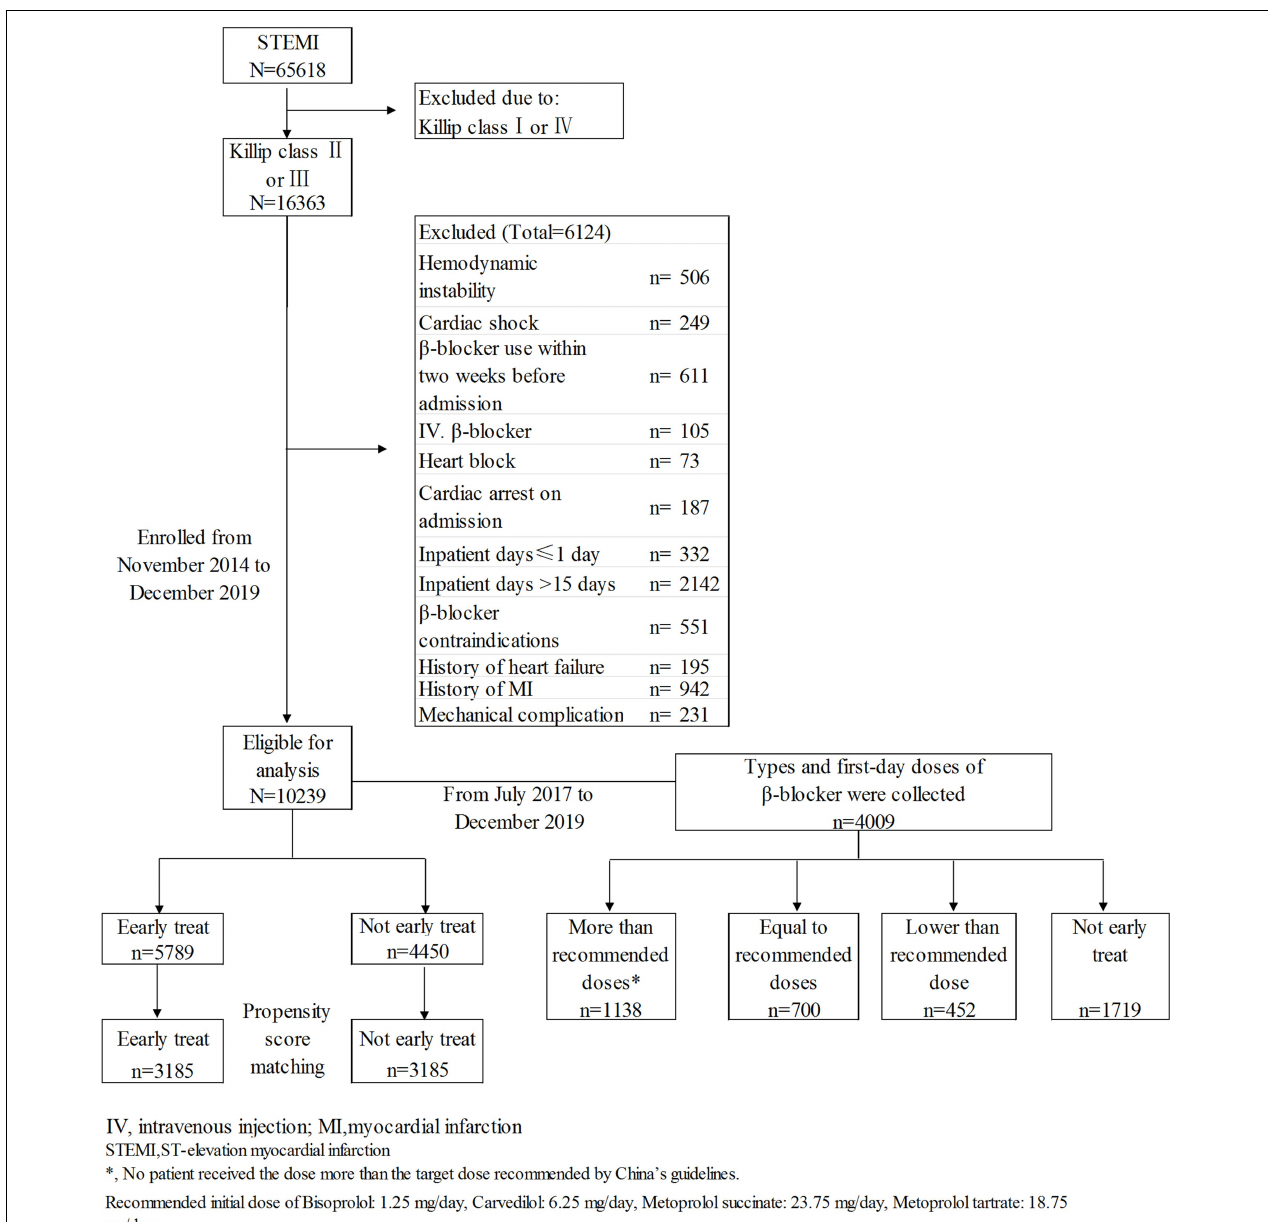
FIGURE 1 | Flowchart of the enrollment